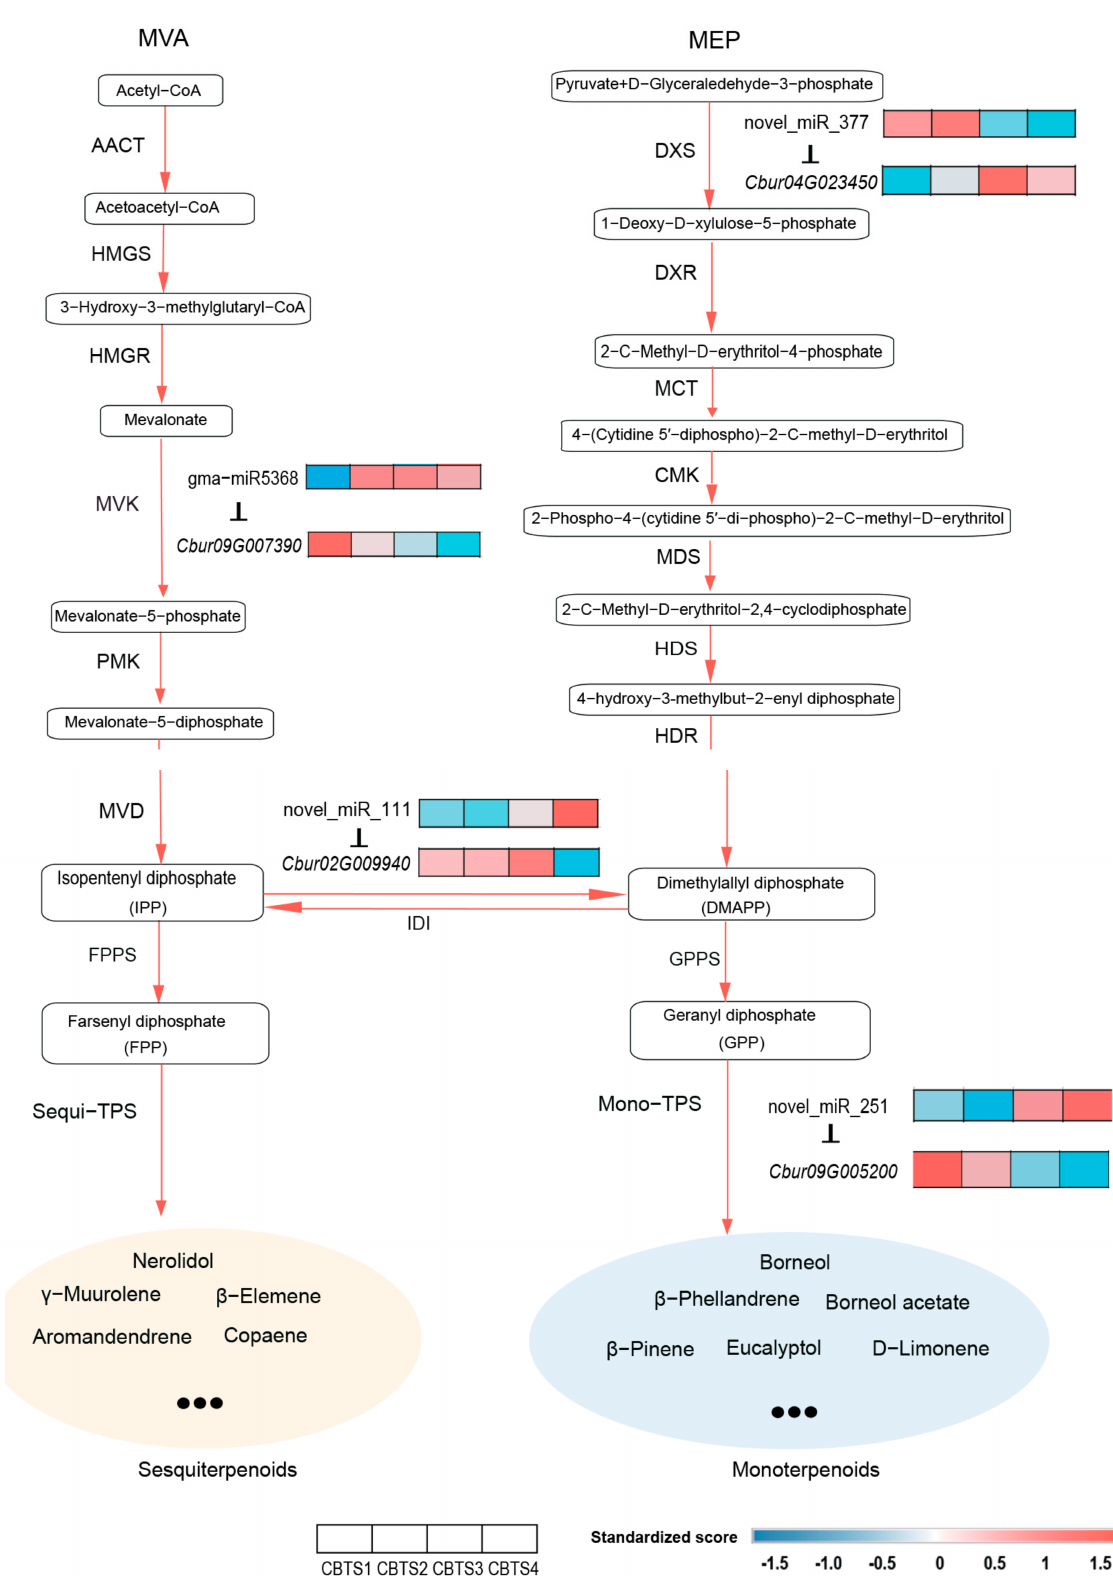
Figure 5. DEmiRNAs and DEGs in the MVA and MEP pathways in C. burmannii . Heatmaps showing the expression levels of the DEMiRNAs and DEGs involved in the MVA and MEP pathways across four leaf developmental stages. The symbol “ ⊥ ” indicates the regulation of gene expression by the miRNAs detected in the present study based on the target gene prediction via